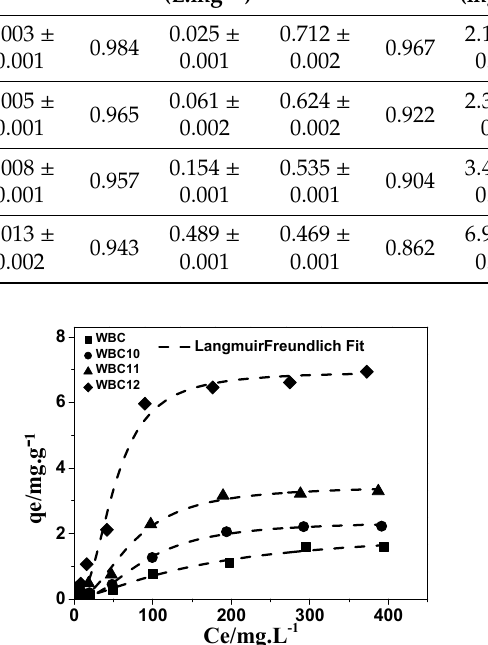
Figure 12. Regeneration of WBC12. 4. Conclusions This study successfully synthesized a novel magnetic adsorbent (WBC1x) by using agricultural waste (a walnut shell) and Fe/Mg nanocomposites to compare their ability in phosphate uptake. The following conclusions can be drawn: (1) WBC1x was prepared through a combination of impregnation and slow pyrolysis at a temperature of 600 °C, which successfully loaded MgO and Fe 3 O 4 onto WBC. As a consequence, all WBC1x have magnetic separation characteristics;